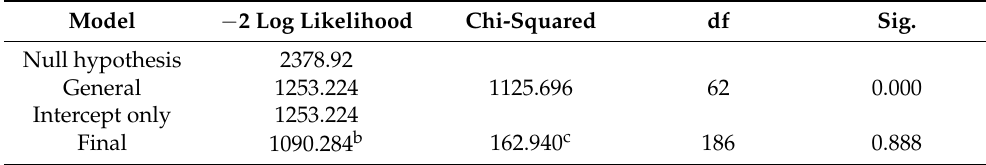
Table 4. Model Fitting information and the parallel line